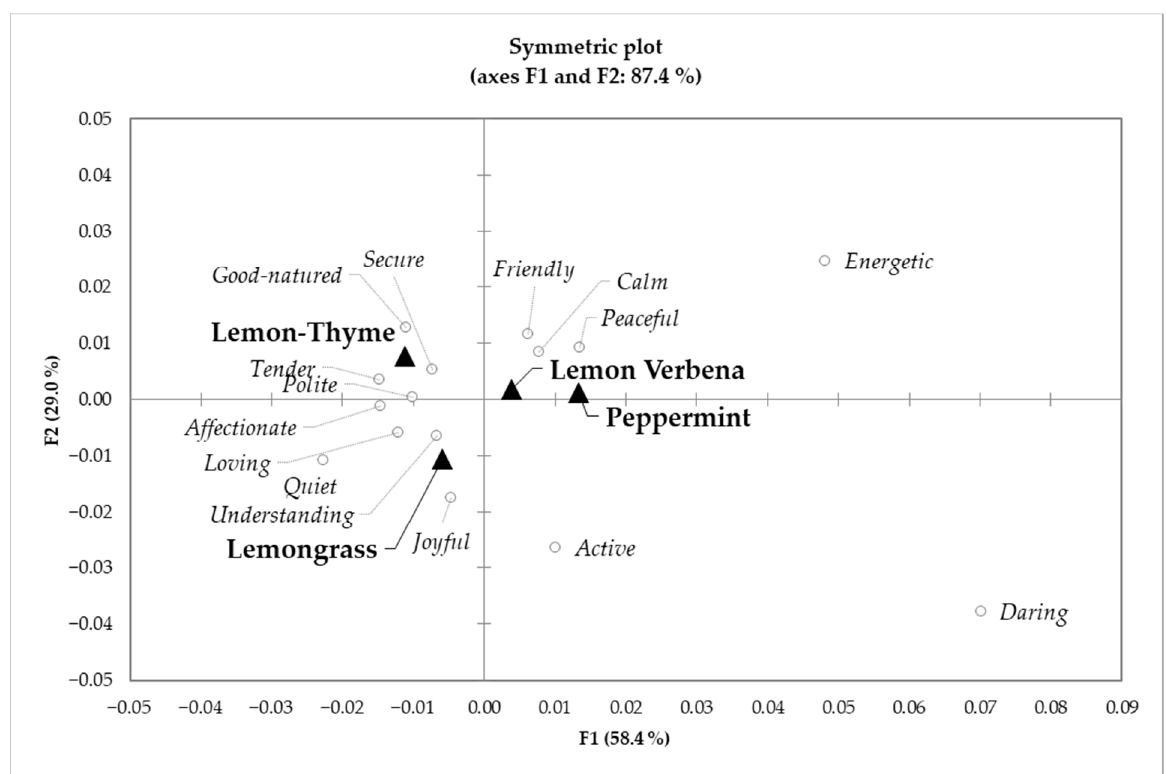
Figure 2. Configurations of samples (triangles) and significant emotion-related terms (circles) in the first and second dimensions of the correspondence analysis applied to check-all-that-apply (CATA) counts from the four infusions: lemongrass, lemon thyme, lemon verbena and peppermint.